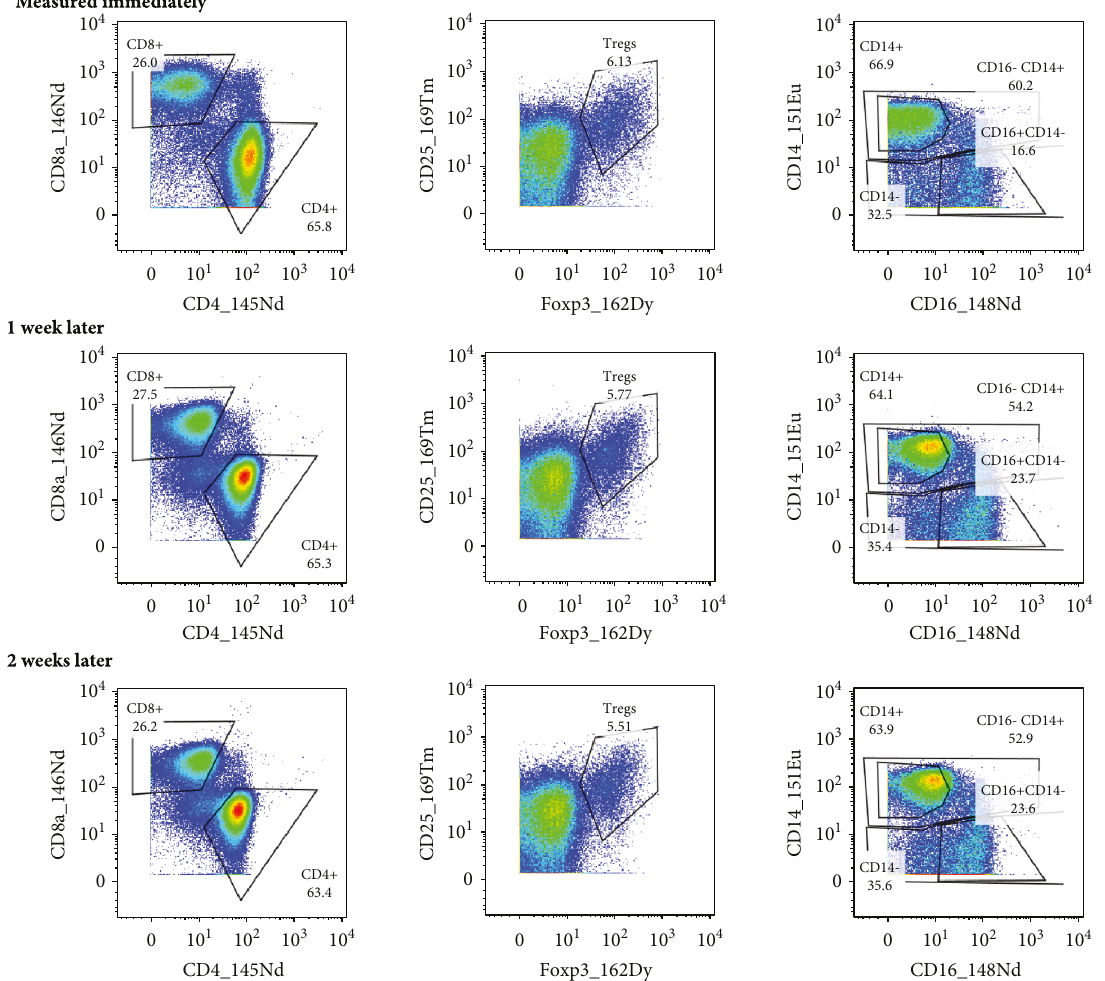
Figure 5: Storage of labeled samples in the intercalator solution. PBMCs were isolated from a blood sample of a patient with HNSCC, stained for live and dead cells, and divided for further labeling. The stained cells were measured the next day or stored in the intercalator solution for one or two weeks. The same gates (adjusted for the sample measured immediately) were applied to measured